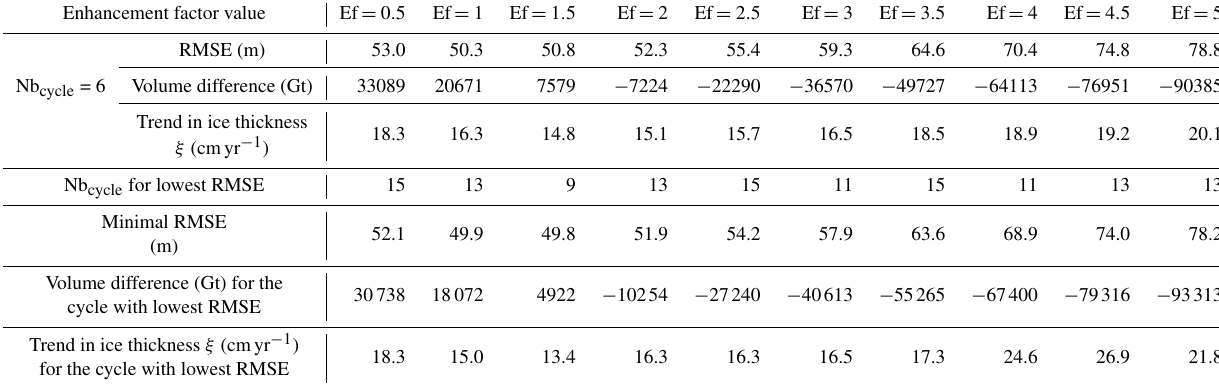
Figure 5. Ice thickness root mean square error with regard to observations from Bamber et al. (2013), in metres for Nb inv = 20, Nb free = 200 and with enhancement factors (Ef) ranging from 0.5 to 5 as a function of the number of iterations (Nb cycle ). Table 1. Integrated metrics computed from the last 5 years of the 200-year free-evolving simulations of the second step (green box in Fig. 3) for Nb inv = 20 and Nb free = 200 with varying enhancement factors (Ef) ranging from 0.5 to 5. Enhancement factor